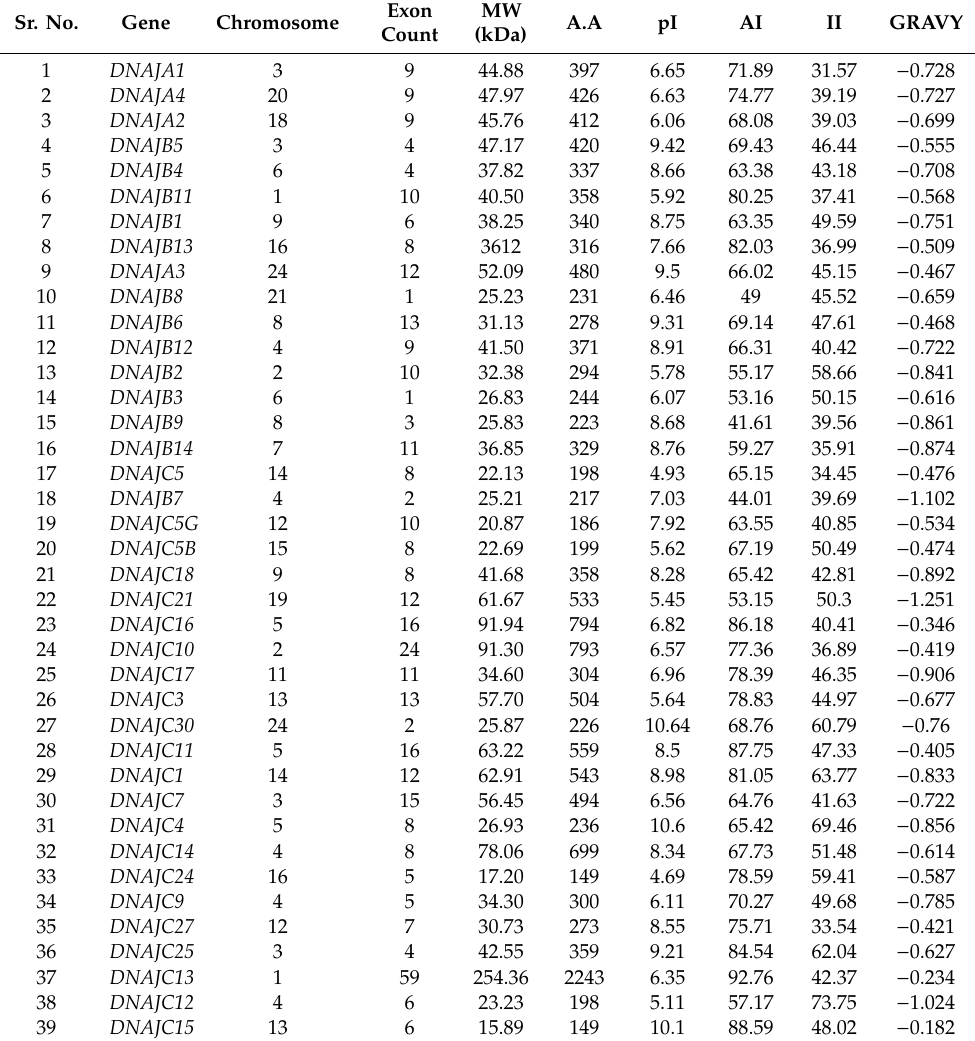
Table 2. Physiochemical Properties of HSP40 gene family members.